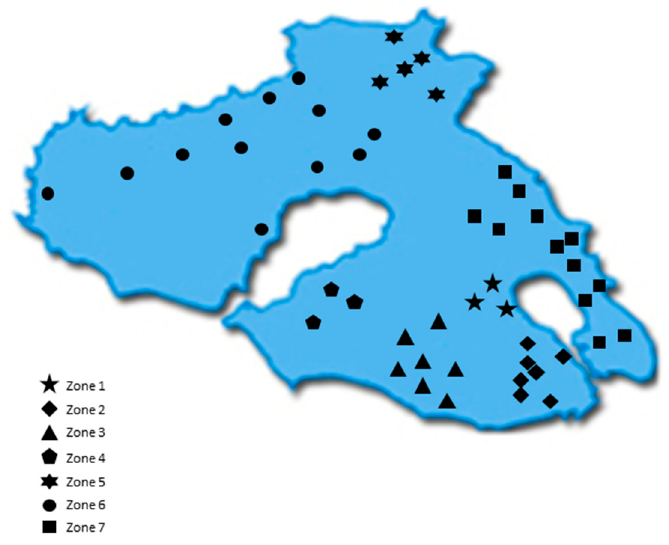
Figure 1. Map of Lesvos indicating the geographical areas (zones) of the